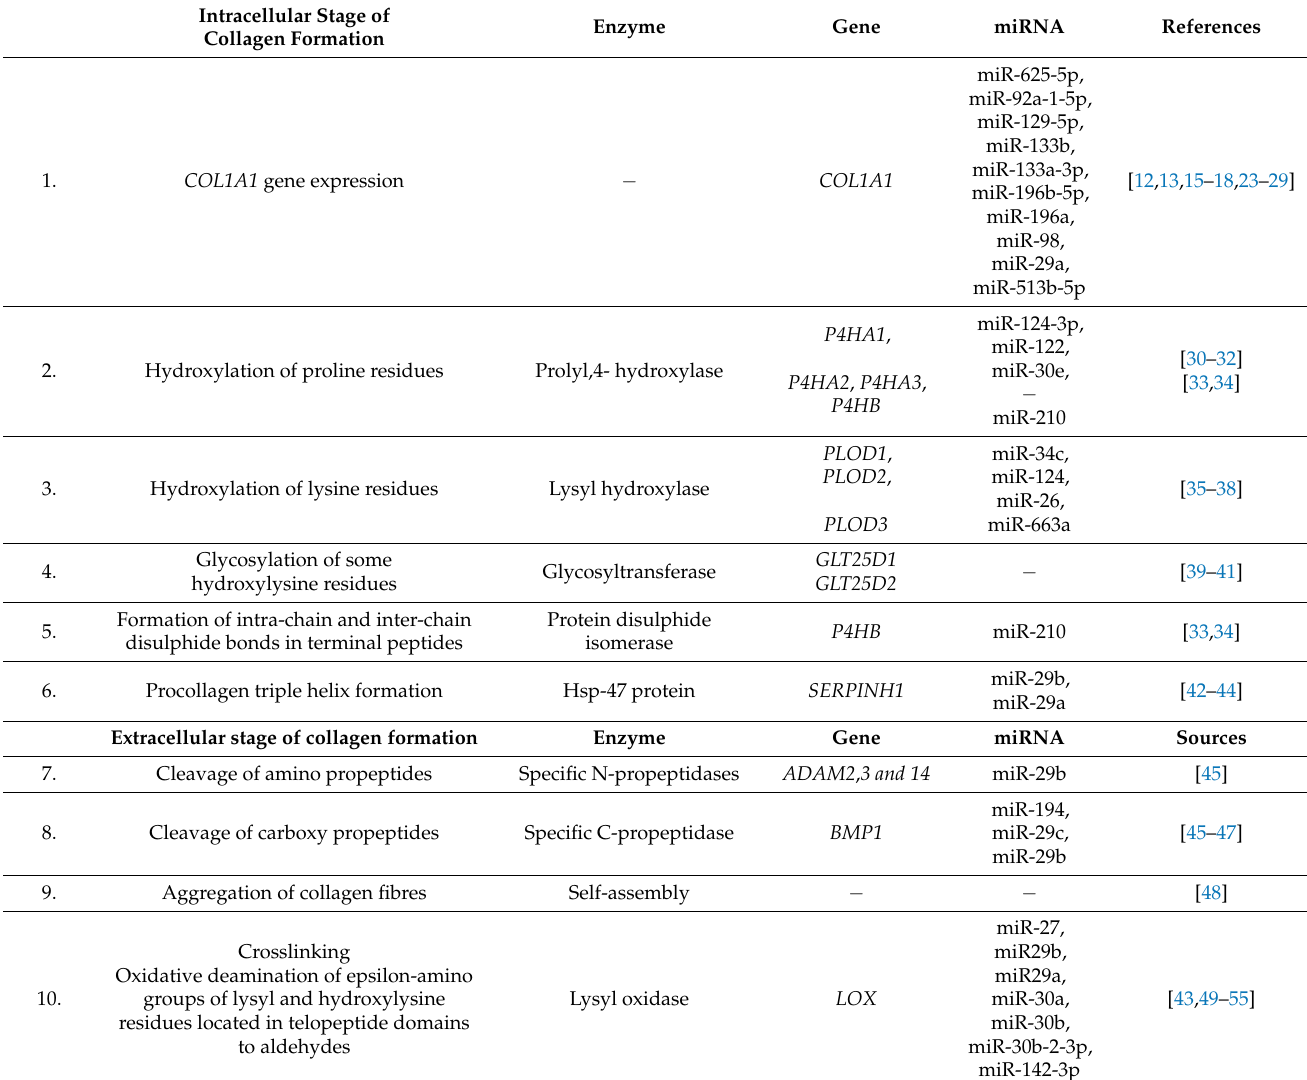
Table 1. The enzymes involved in the crucial stages of collagen